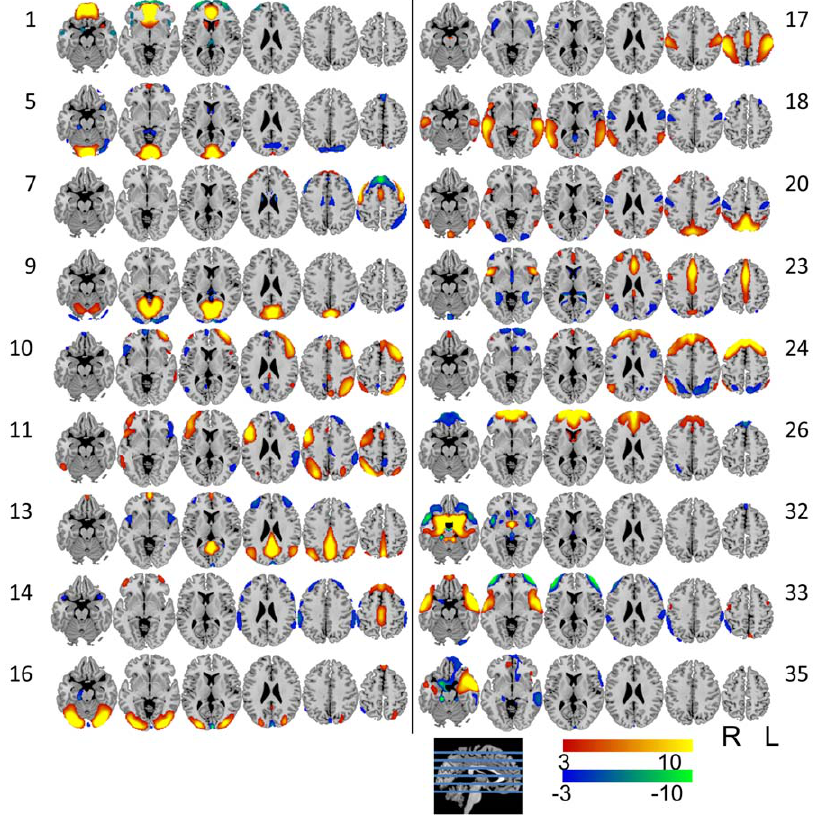
Figure 2. The eighteen spatially independent task-related components. The components are numbered using the arbitrary ordering resulting from the ICA which extracted 36 total components.